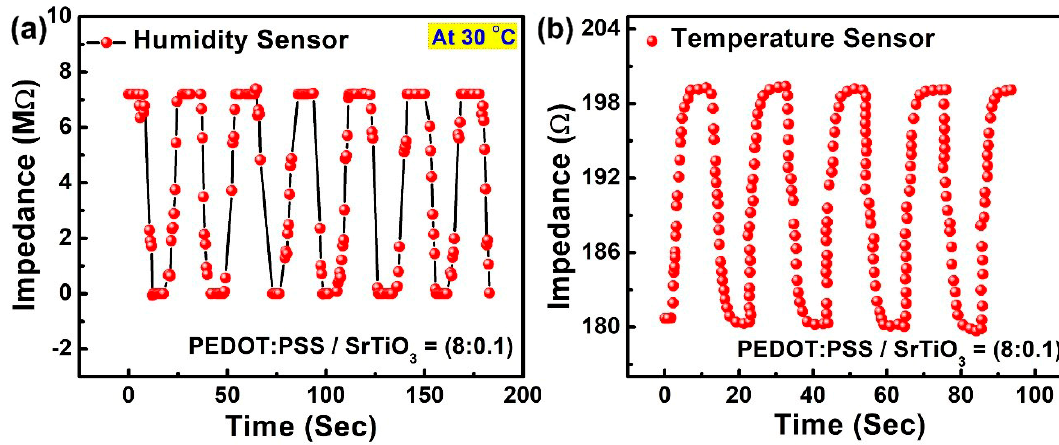
Figure 7. Cyclic response of the sensor: ( a ) relative humidity change from 10% RH to 90% RH; ( b ) temperature change from 30 °C to 80 °C.